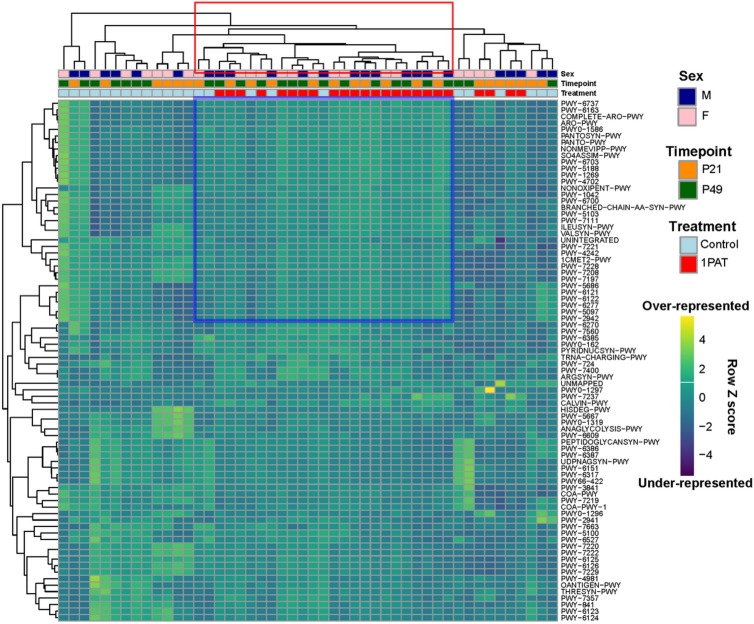
Metagenomic analysis of microbiota characteristics of 1PAT and control NOD mice in early life.Unsupervised clustering of the microbial pathways with the 25% highest variance. A group of 34 specific pathways in the 1PAT mice, regardless of time or sex are outlined with a blue box.